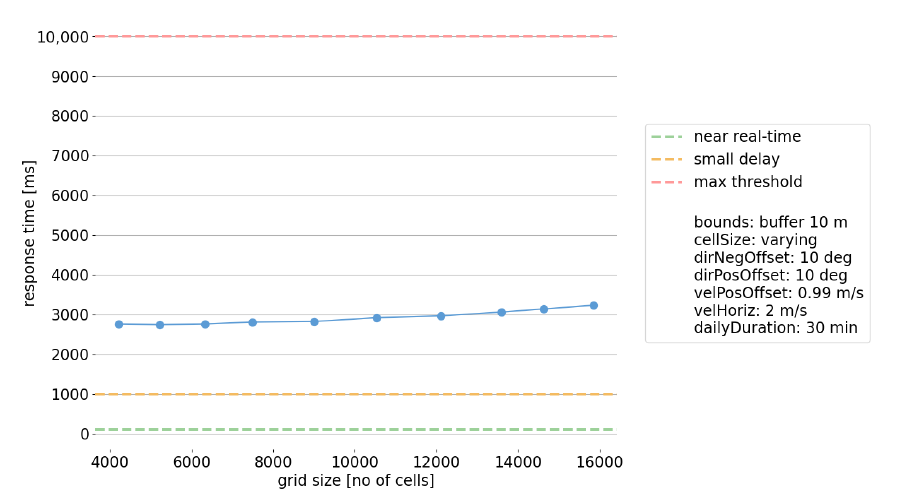
Figure 16. The response times and the grid size when the grid cell varies. The direction_plan and duration_plan results showed that the wind direction offsets and the daily duration of the wind have insignificant impact in the response times in realistic scenarios, i.e., wind velocity above 2 m/s and a spatial buffer around the buildings of 10 m (Figures 17 and 18).